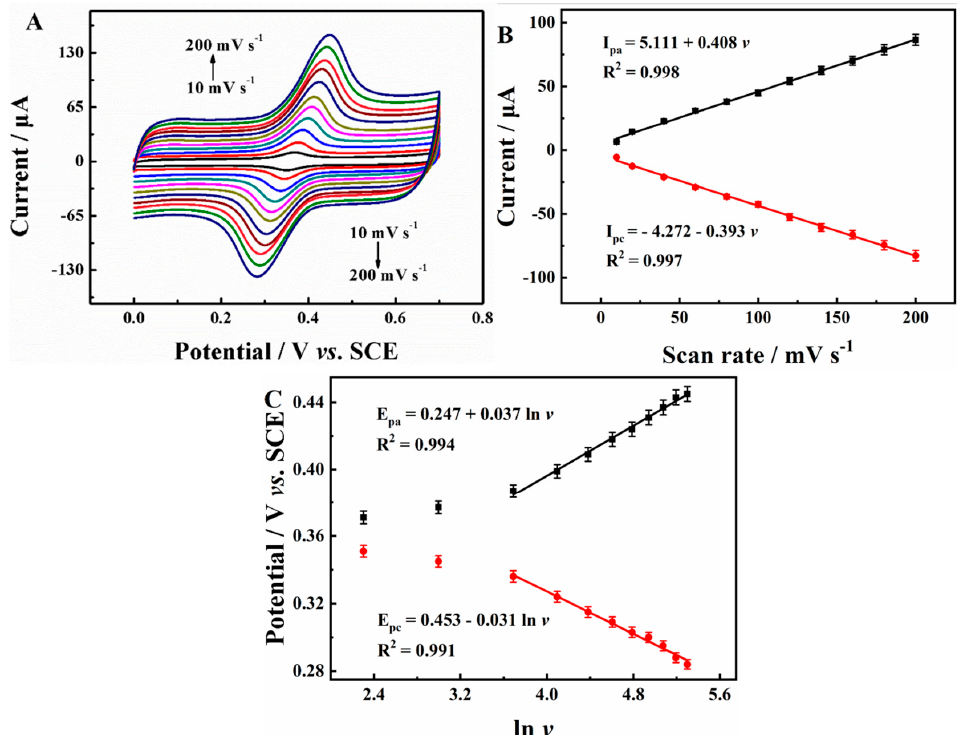
Figure 6. ( A ) CVs of N-SC/ β -CD-MOFs/GCE in 0.1 M PBS (pH 7.0) with 20.0 μ M AC at different scan rates (10, 20, 40, 60, 80, 100, 120, 140, 160, 180 and 200 mV s − 1 ); ( B ) Linear relationship between the peak current of AC and scan rates. ( C ) The relationship between the redox peak potentials of AC and ln ν .